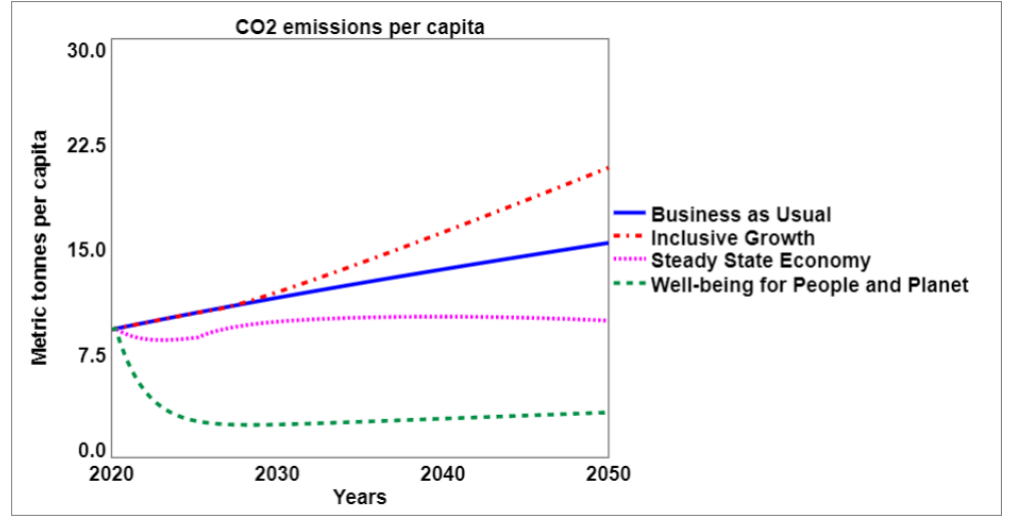
Figure 12. CO 2 emissions per capita in the four